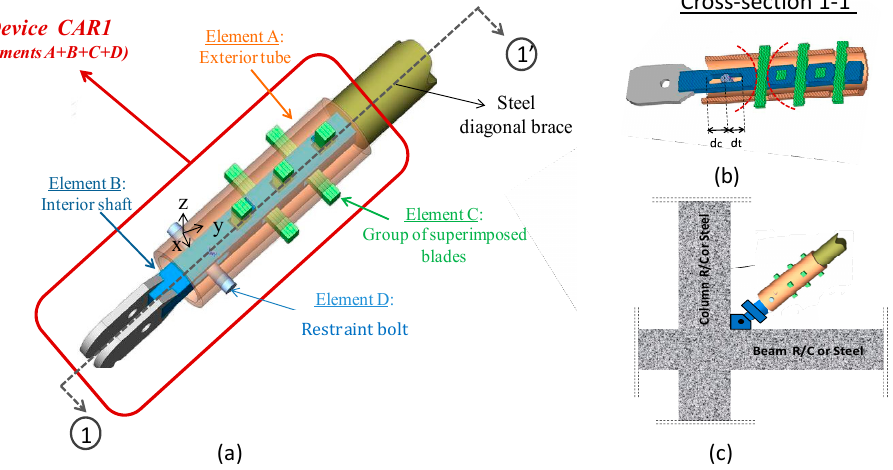
Figure 7. Description of CAR1 damper, proposed and investigated by Titirla et al. [73]. ( a ) The proposed steel device CAR1, ( b ) the cross section 1-1’ of the device CAR1, ( c ) connection of device in RC or Steel structures.